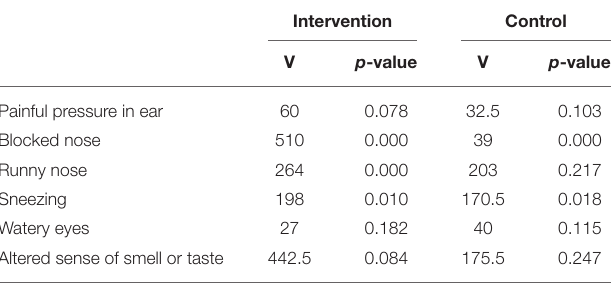
TABLE 3 | Test of within-group differences in symptom frequency between assessments. Intervention